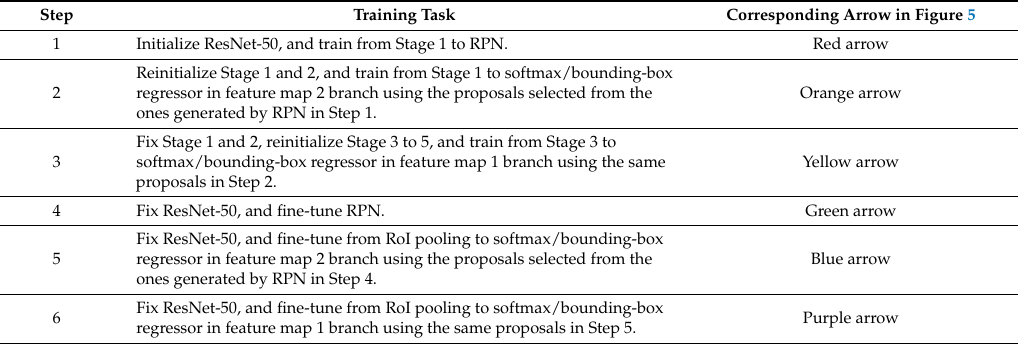
Table 1. The training steps of the neural